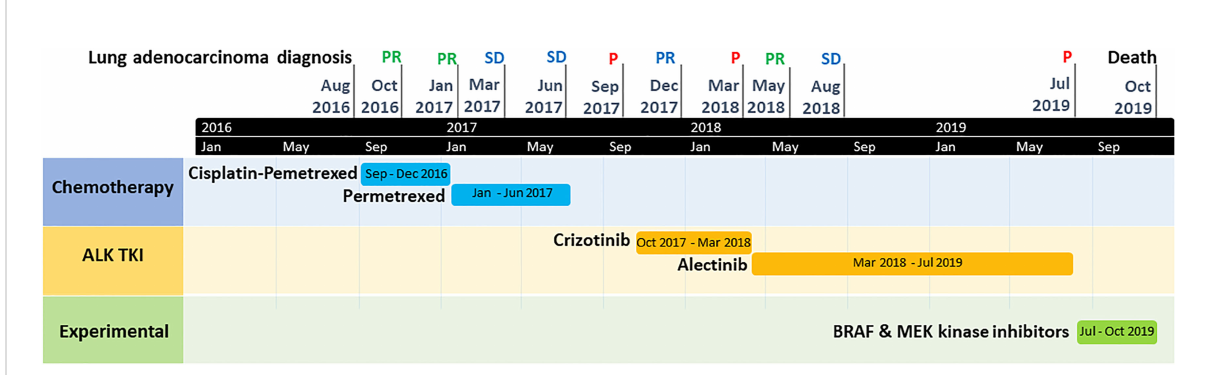
FIGURE 3 Timeline graph of patient clinical history, with tumor evolution and treatments. P, tumor progression; PR, tumor partial response; SD, tumor stable disease; TKI, tyrosine kinase